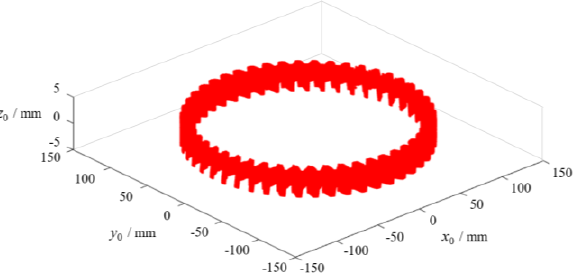
Figure 7. Point clouds obtained with one − rotation measurement.